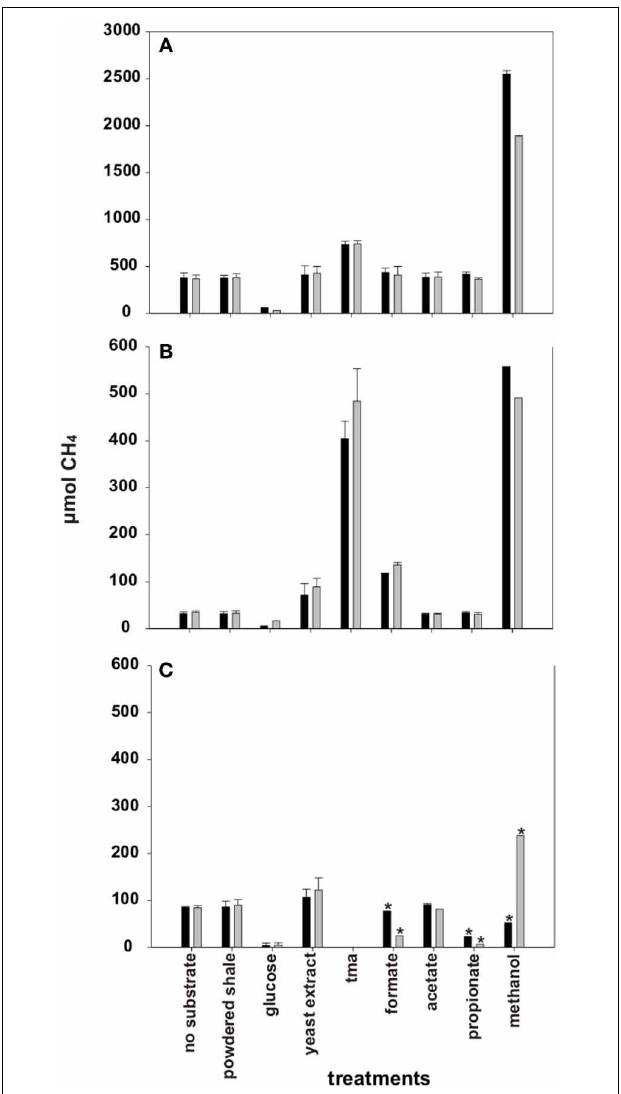
FIGURE 4 | Average methane accumulation in formation water over the course of incubation with and without added substrates. (A) A3-11 and (B) B1-12 well waters were incubated for 202 days and (C) C1-12 well was incubated for 240 days. TMA was not tested with C1-12 well water. Note: Y-axis for (A) is 5X larger in magnitude than (B,C) . ∗ Incubation bottles where methane formation had not yet reached a plateau after 240 days of incubation. Therefore, the endpoint methane yields are shown, incubation bottle 1 (black), incubation bottle 2 (gray).